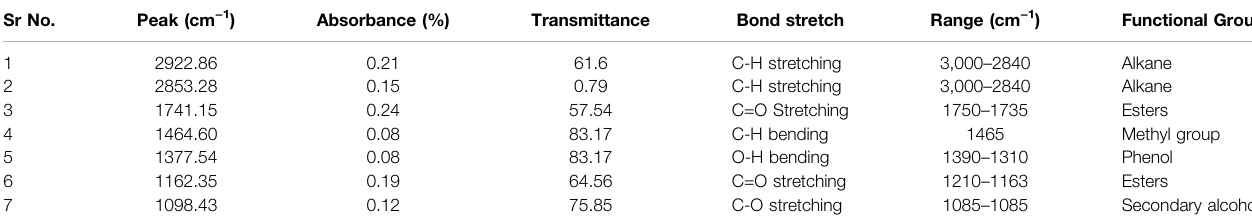
TABLE 3 | FTIR of oil extracted from Cucumis melo var. agrestis seed. Sr No.